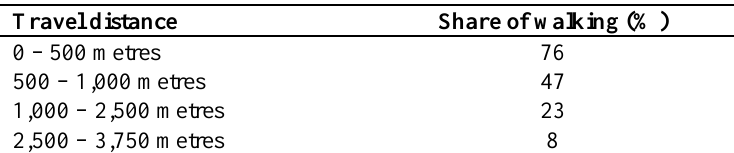
Table 1. Walking as percentage of all trips for different travel distances (National Travel